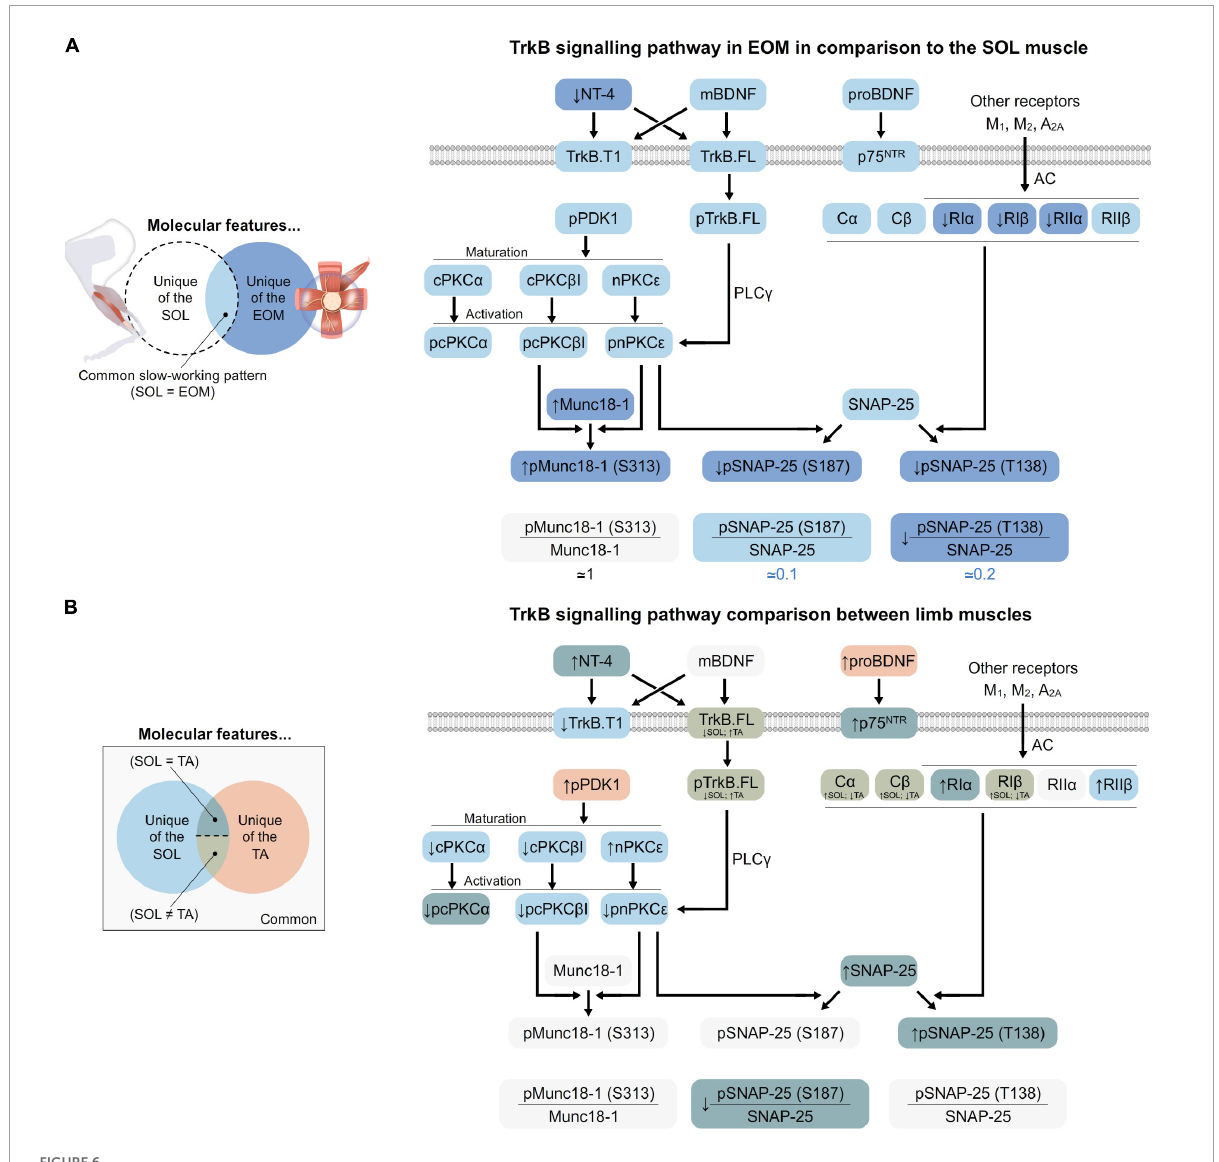
FIGURE6 Graphical representation of the TrkB signaling pathway at the NMJ. (A) EOM in comparison with SOL. EOM muscles share several molecular features with SOL, represented in pale blue. However, they also have some unique features (dark blue), whose relationship with SOL is indicated by arrows ( ↑ for increase and ↓ for decrease). These characteristics are possibly involved in the ability of EOM to contract fast without being fatigued despite continuous usage. (B) The different limb muscles. Limb muscles share a few molecular features (pale gray). Also, the TA muscle has some unique features (orange). On the other hand, SOL’s unique features are always coincident with EOM (pale blue; like in panel A). Finally, some proteins equally change in SOL and TA in relation to EDL (dark green). Thus, two levels of adaptations to resistance to fatigue can be spotted depending on if they are exclusive of SOL or shared with TA. Finally, TA also shows some characteristics that could be involved in the differences between flexor and extensor muscles as they are different from SOL and EDL (pale green). The BDNF/TrkB downstream signaling is always the same at the NMJ, but the different proportions of proteins allow the adaptation to the precise requirements of each muscle and vice versa. In brief, proBDNF preferentially binds p75 NTR while mBDNF and NT-4 selectively bind and activate either full length or truncated TrkB. When TrkB.FL is not inhibited by heterodimerization with truncated isoforms, it activates PKCs in the membrane, which has been previously phosphorylated by PDK1. This is mediated by PLC γ , which enhances intracellular Ca 2 + and DAG concentration. At the plasma membrane, PKCs modulate ACh release by phosphorylating exocytotic machinery proteins such as Munc18-1 and SNAP-25. Furthermore, SNAP-25 is also phosphorylated by PKA, whose activity depends on muscarinic ACh receptors, among